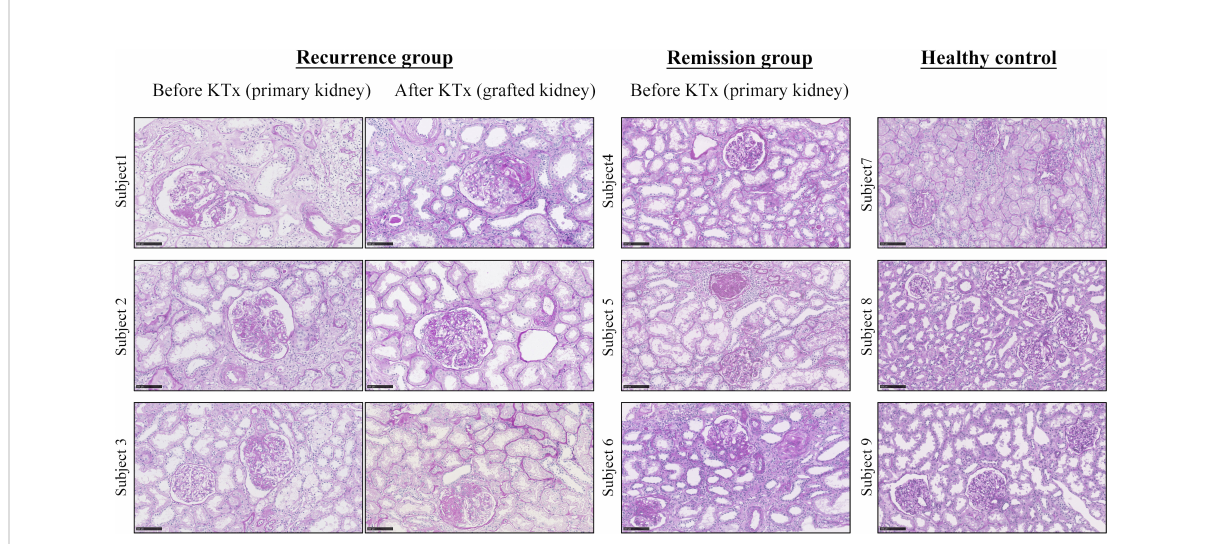
FIGURE 1 Representative pathology from FSGS patients before and after KTx by Periodic acid-Schiff staining. Note that focal segmental glomerular sclerosis with fi brosis is apparent in all FSGS patients before KTX and is also found in those with recurrent FSGS patients after KTx. Because KTx largely improved progressive renal injury in those FSGS patients, no renal biopsy was performed in the remission patients after KTx based on the ethical reasons. The healthy control kidneys are obtained from unmatched donor kidneys. Scale bar: 100um. KTx, kidney